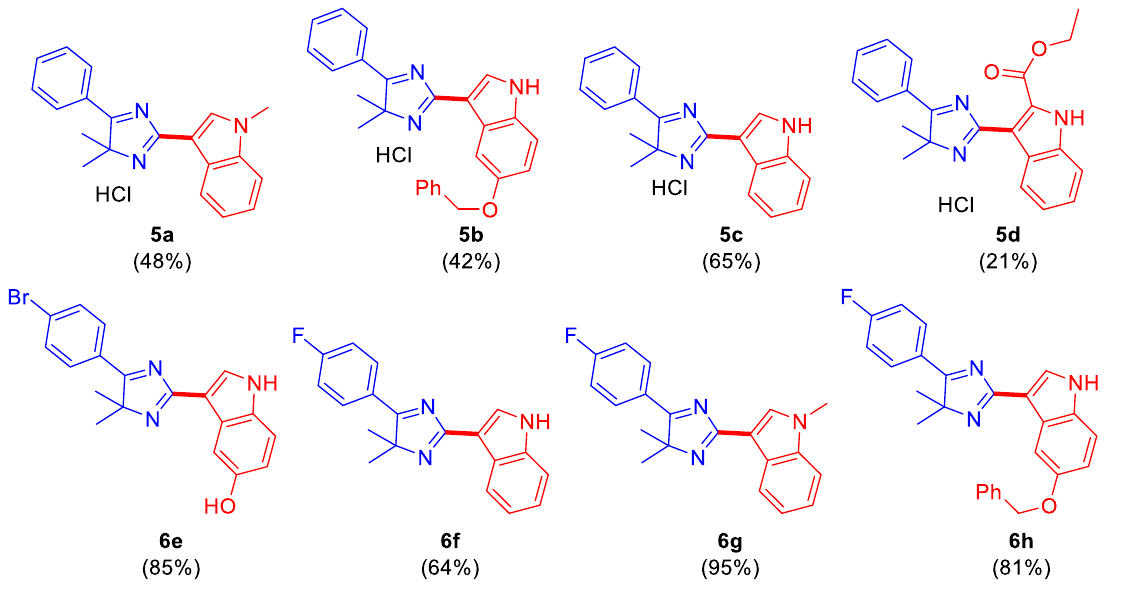
Figure 2. Structures and yields for the obtained indolyl-derived 4 H -imidazoles. (Blue color indi- cates the imidazole ring, red color shows the indole